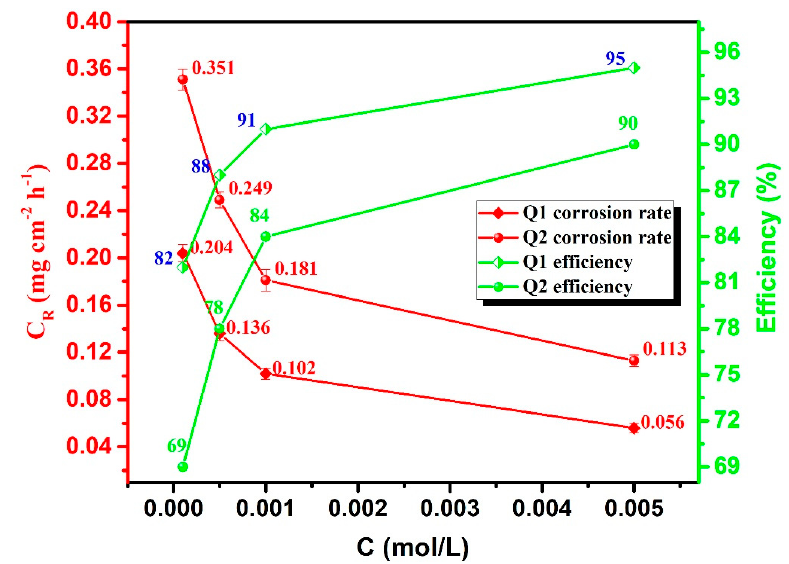
Figure 1. The variation of the corrosion rate (±SD) and the inhibition efficiency with Q1 and Q2 concentrations for mild steel in 1.0 M HCl at 303 K.